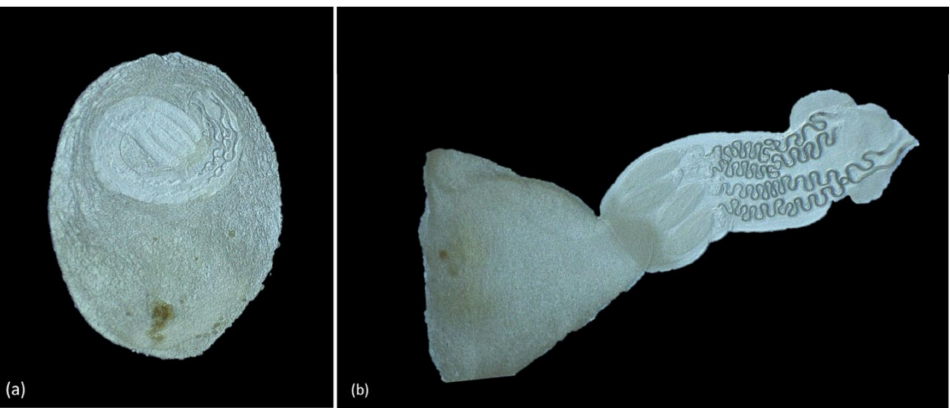
Figure 9. Plerocercus under stereoscope (0.75 × ). ( a ) Plerocercus within blastocyst. ( b ) Scolex of the plerocercus emerging from the blastocyst.